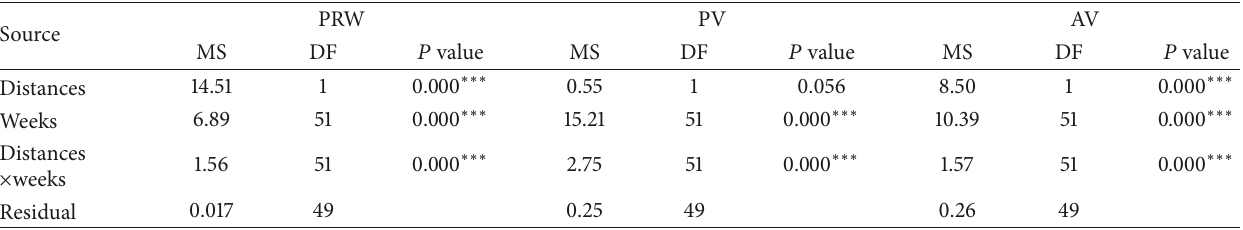
Table 2: ANOVA for ascospores on Vaseline (AV), pycnidiospores on Vaseline (PV), and pycnidiospores on rainwater (PRW) sampled at different distances and weeks during the first period (1998-1999).